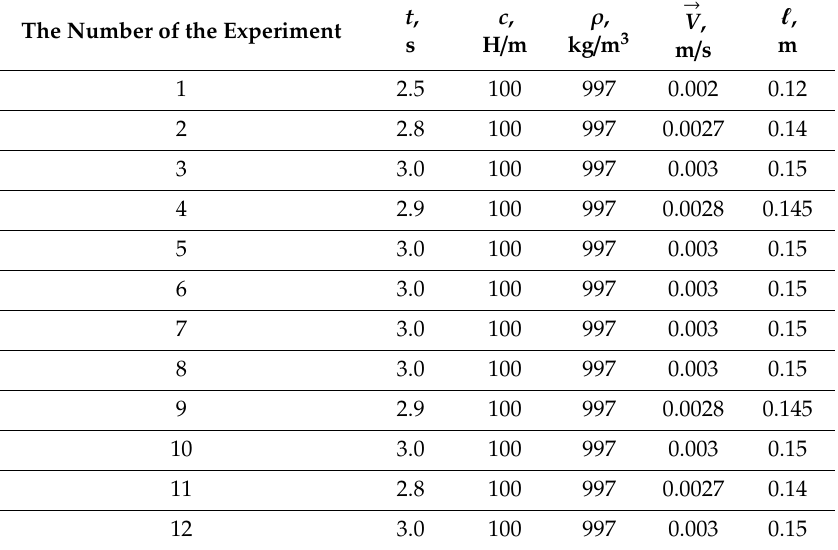
Table 1. Experimental results of the movement of the body under the action of a sound wave. The Number of the Experiment